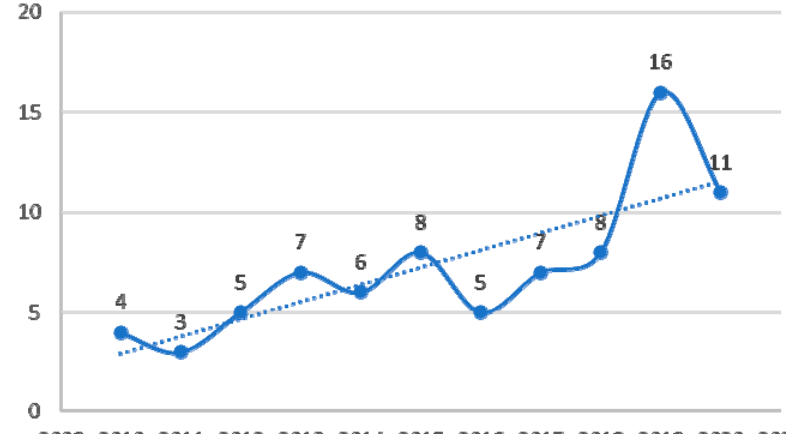
Figure 3. Number of publications per year.